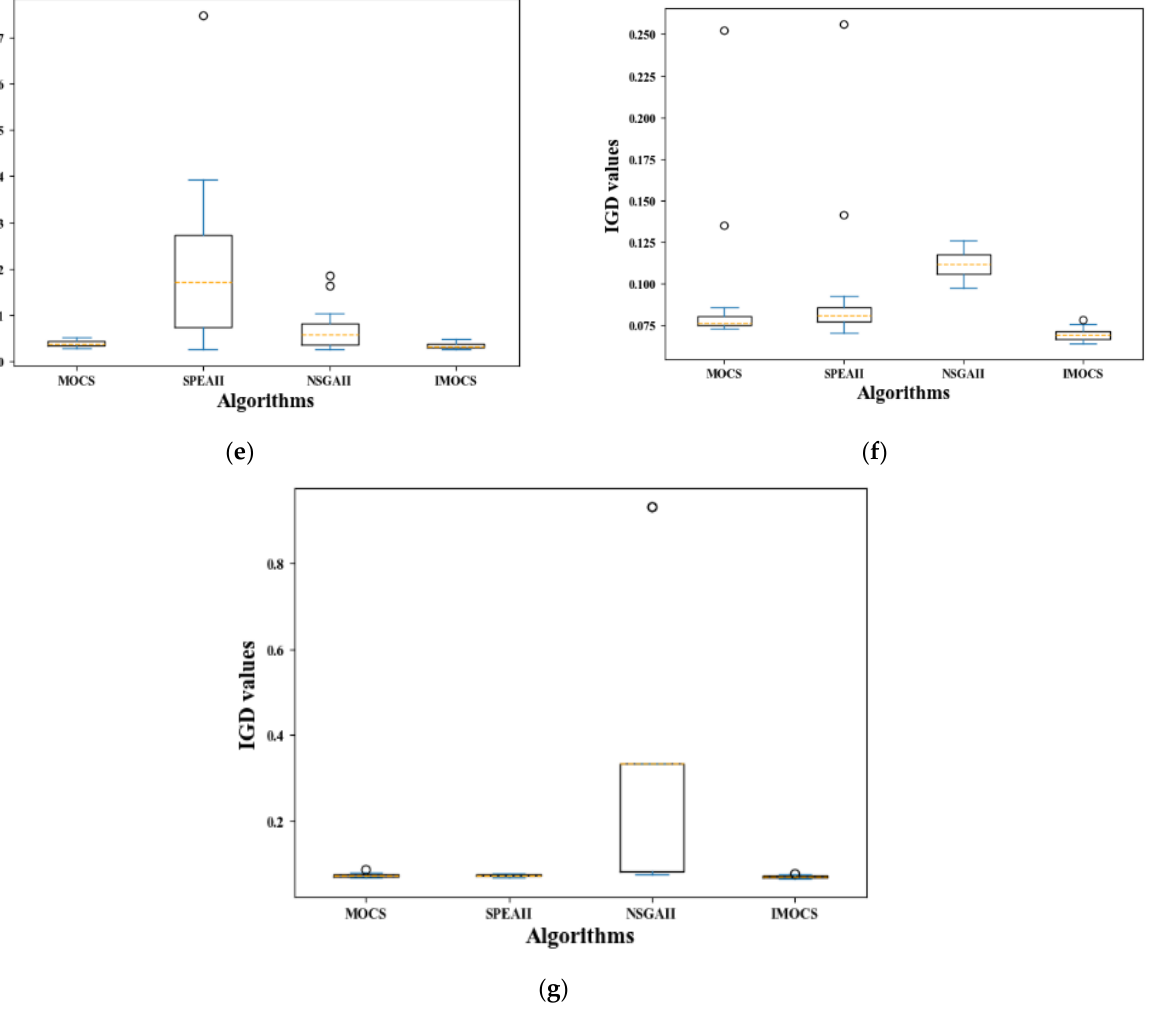
Figure 10. The results of IGD test problem over all algorithms. ( a ) ZDT1, ( b ) ZDT2, ( c ) ZDT3, ( d )